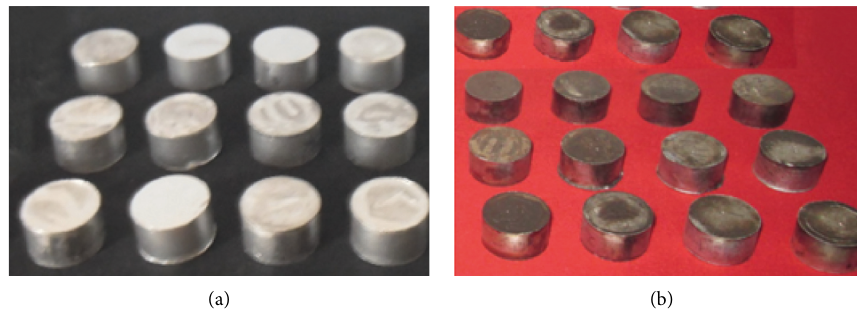
Figure 4: Sintered specimens: (a) before sintering; (b) after sintering.